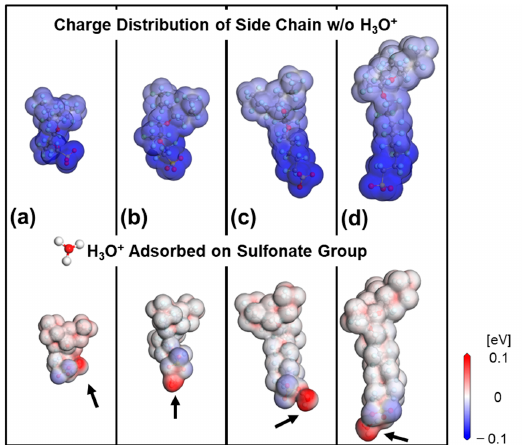
Figure 4. Charge distribution of the side chain before and after H 3 O + is adsorbed on the negatively charged sulfonate group. H 3 O + adsorption leads to neutralization despite the chain length. The length index y corresponds to each of the ( a )–( d ) side chain is 1, 2, 5 and 8, respectively. On the other hand, we considered the binding energy resulting from van der Waals forces driven by induced electrical interactions between two close atoms. The three posi- tions selected to calculate binding energy are as shown in Figure 5a, close to the backbone, middle of the side chain, and around the adsorption of the sulfonated group and hydro- nium. The binding energy of the hydrogen molecules on side chain with adsorbed H 3 O + ranged from − 0.005 to − 0.02 eV (Figure 5b–d), obviously referring to physical adsorption between them, with the distance ranging from 3.0 to 3.5 Å Therefore, we can safely con- clude that van der Waals interaction has a negligible effect on hydrogen molecular behav- ior into the polymeric membrane, although the longer side chain offers a wider surface for physisorption.